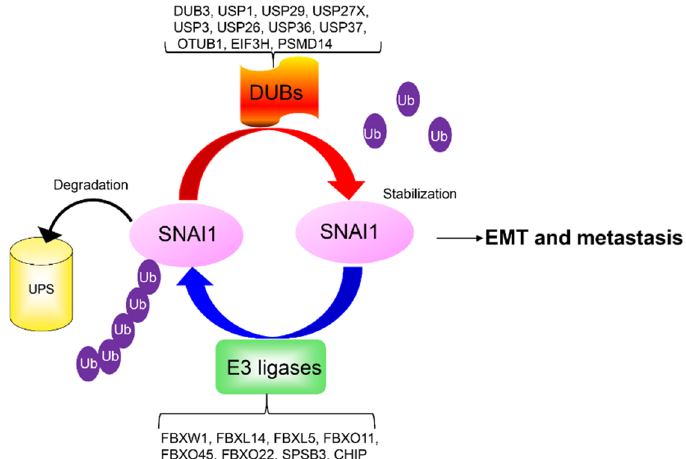
Figure 2. The ubiquitination and de-ubiquitination of SNAI1. SNAI1 is degraded by multiple E3 ligases. By contrast, de-ubiquitinases counteract E3 ligase activity and prevent SNAI1 degradation. USP: ubiquitin-specific protease; OTUB1: OTU deubiquitinase, ubiquitin aldehyde binding 1; PSMD14: proteasome 26S subunit, Non-ATPase 14; EIF3H: eukaryotic translation initiation factor 3 subunit H; DUB: deubiquitinase; UPS: ubiquitin/proteasome system; FBXW1: F-box/WD repeat-containing protein 1; FBXL: F-box and leucine rich repeat protein; FBXO: F-boxes other; SPSB3: SplA/ryanodine receptor domain and SOCS box containing 3; CHIP: carboxy-terminus of Hsc70 interacting protein.